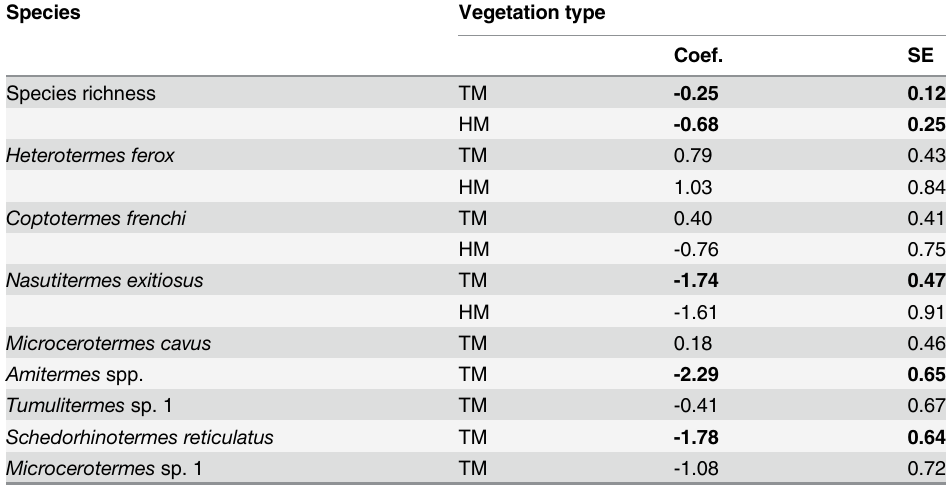
Table 4. Summary of generalised linear mixed models of termite species occurrence at the site scale in relation to vegetation type (CM = Chenopod Mallee; TM = Triodia Mallee; HM = Heathy Mallee). HM was removed from the model when a species was absent at all sites in this vegetation type. Coefficients of explanatory variables (and standard errors) shown in bold are those for which the 95% confidence intervals of coefficients did not include zero. Chenopod mallee is used as the reference category of vegetation.